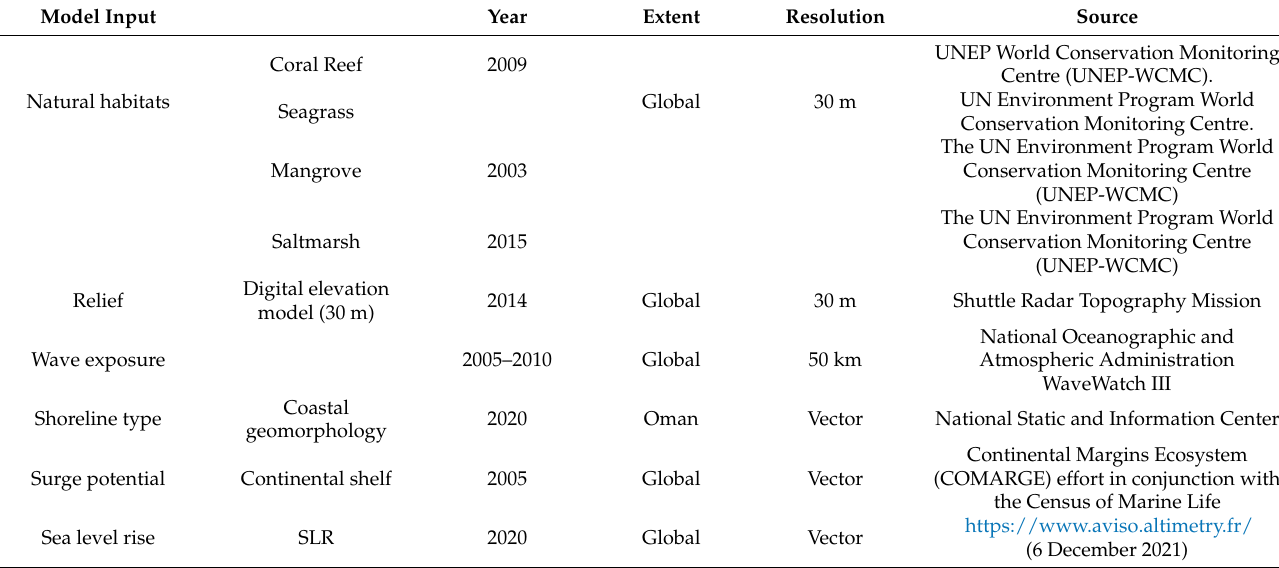
Table A1. Coastal vulnerability model data inputs and